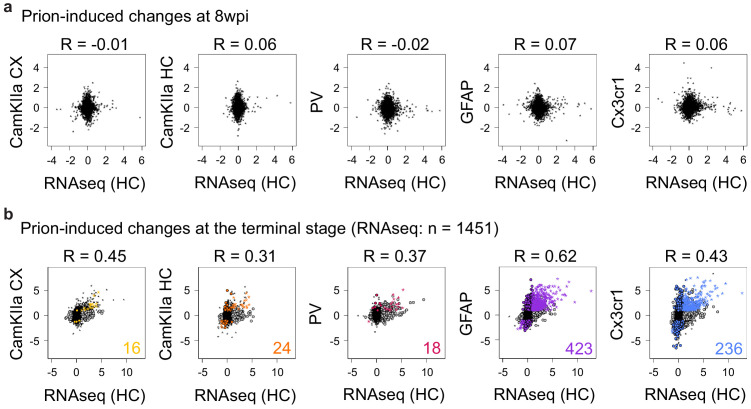
Comparison of prion-induced changes in RNA expression and translation.(a) Comparison between prion-induced cell-type-specific translational changes and RNA expression changes in the hippocampus at 8 weeks post-inoculation (wpi). Pearson correlation coefficients are indicated. (b) Comparison between prion-induced cell-type-specific translational changes and RNA expression changes in the hippocampus at the terminal stage. Pearson correlation coefficients are indicated. Genes that change in either expression (n = 1451; grey circles) or in translation (colored circles) or in both datasets (colored stars, the corresponding numbers are displayed) are indicated.